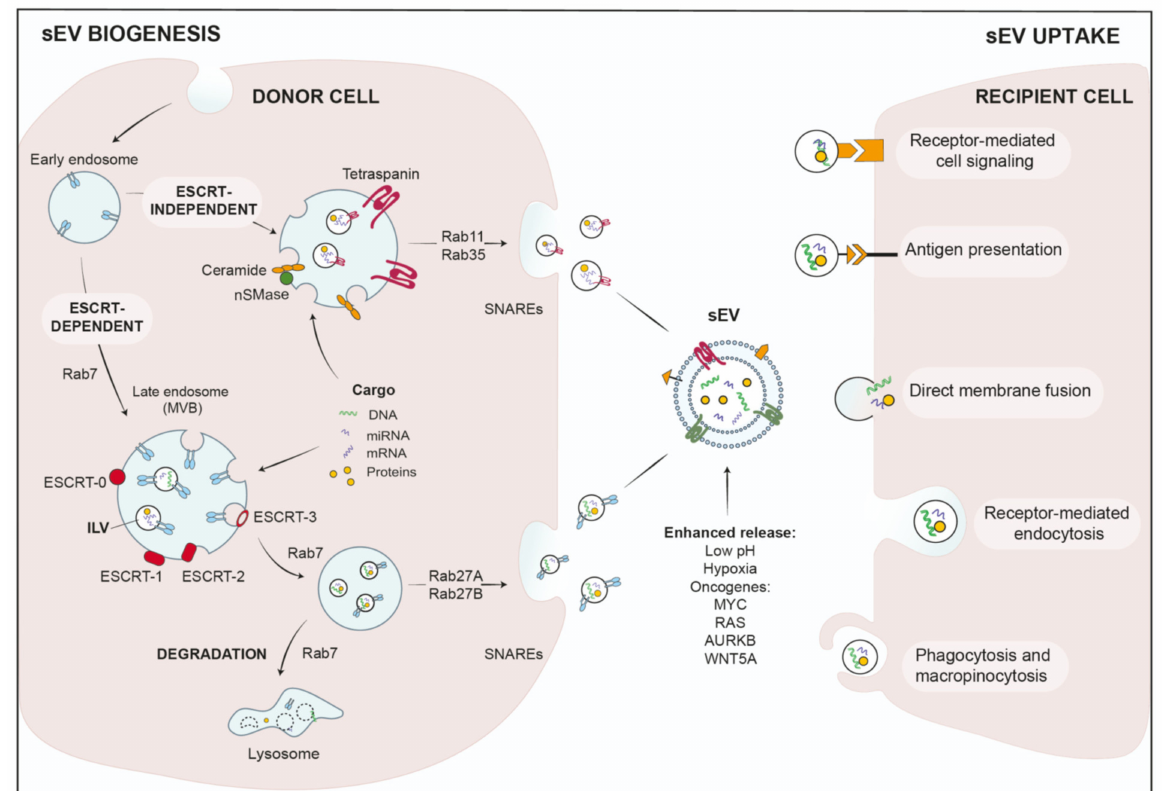
Figure 1. Mechanisms of sEV biogenesis and